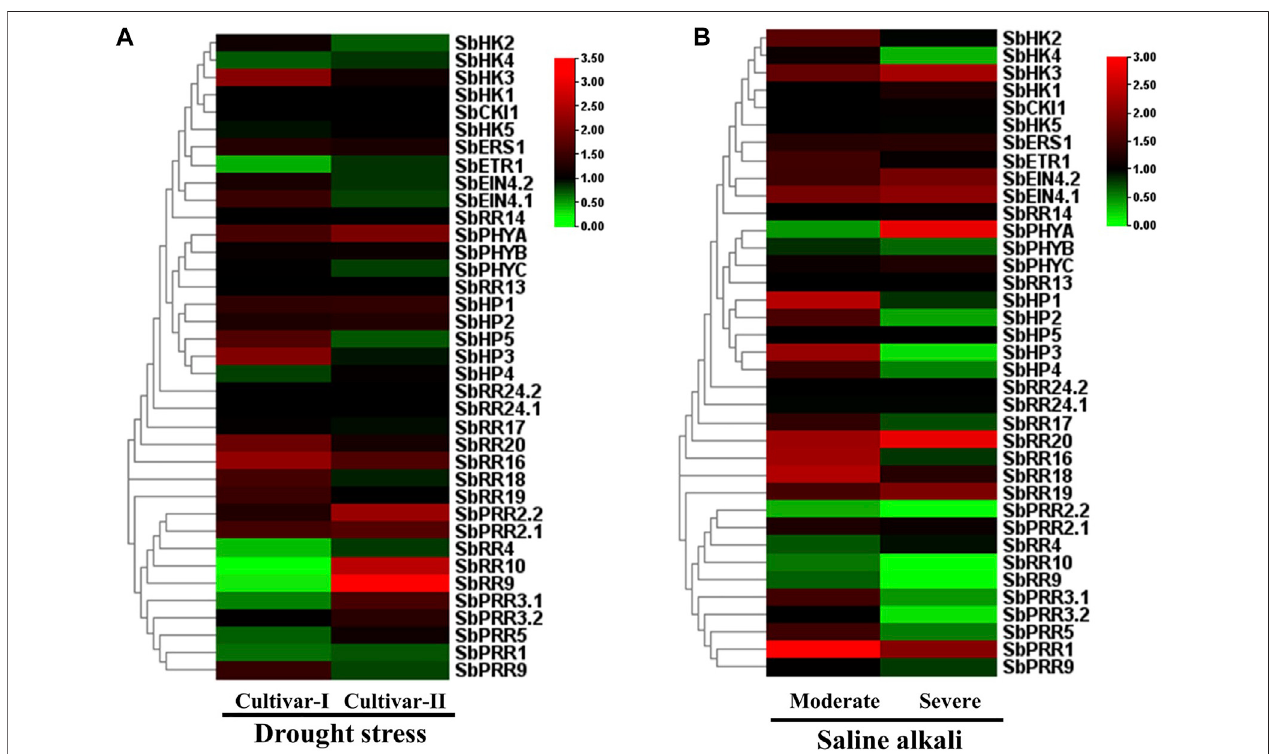
FIGURE6| Heatmaprepresentingtheresponsepatternsof SbTCS genesunderdrought (A) andsalt (B) stresses.Redcolorrepresentsup-regulation,greencolor represents down-regulation and black color represent there is no change in expression.